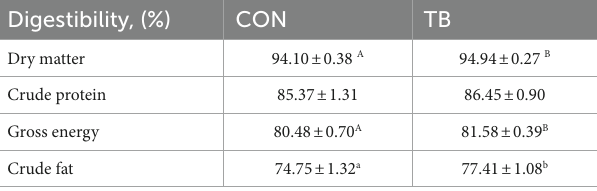
TABLE 6 Effects of tributyrin on dietary nutrient digestibility in sows.